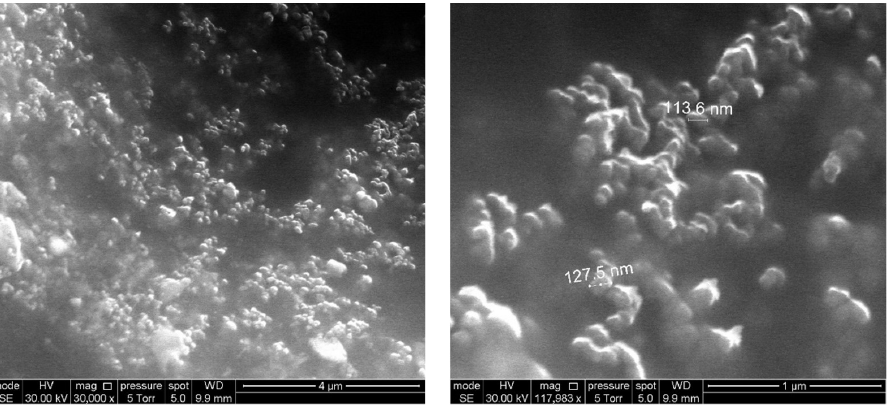
Figure 4. Examples of SEM images of DNDamine coating with a nanodiamond content of 2.3 × 10 −4 g·cm −2 on the surface of polymer F42.